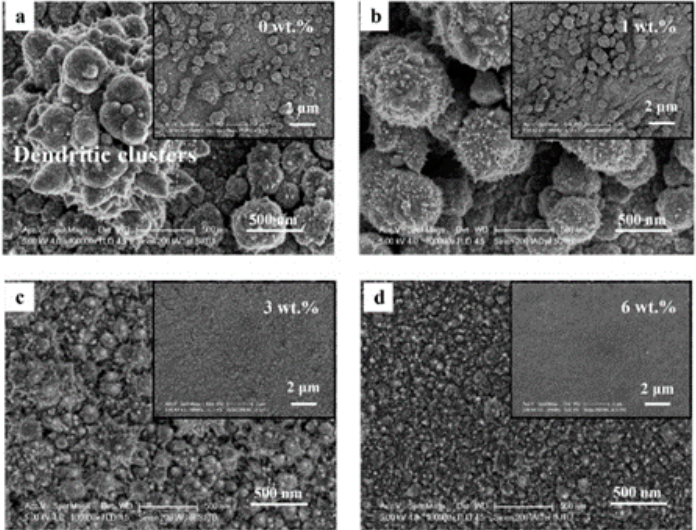
Figure 2. Micrographs of the Ni coatings electroplated from the ChCl-2Urea-(0.2 M)NiCl 2 electrolyte containing ( a ) 0 wt.%, ( b ) 1 wt.%, ( c ) 3 wt.% and ( d ) 6 wt.% water at 318 K. [Reproduction with